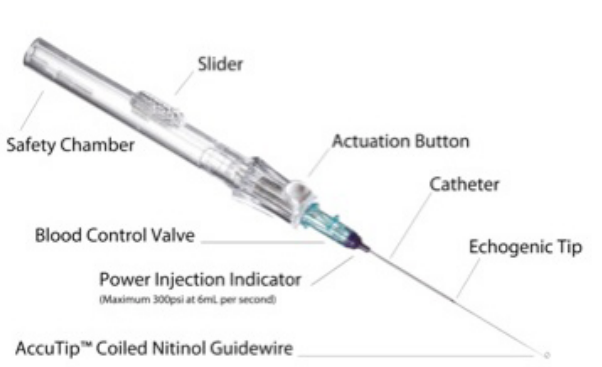
Figure 1. AccuCath® 2.25” BC